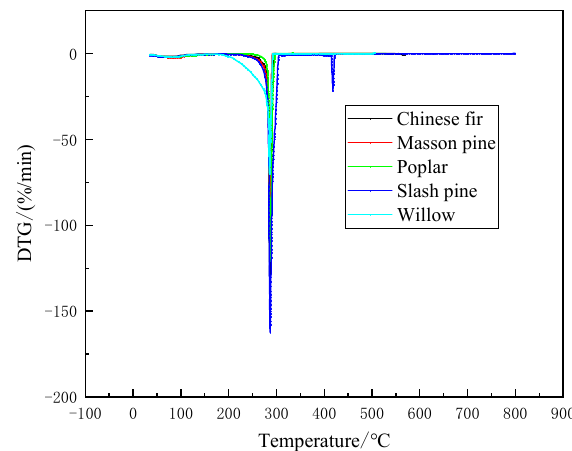
Figure 2. DTG curves of five kinds of biomass pellet fuel.